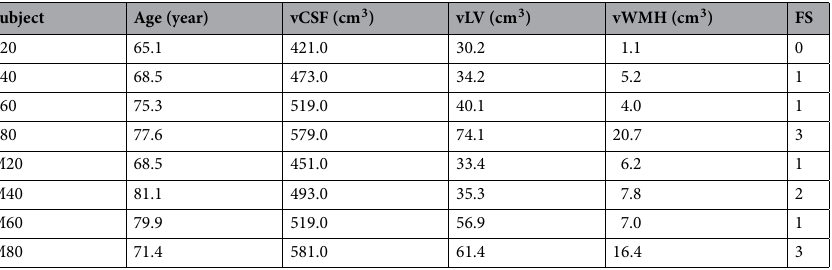
Table 1. Summary of subject data including age, CSF volume (vCSF), lateral ventricle volume (vLV), WMH volume (vWMH), and Fazekas score (FS). We selected eight representative cognitively normal subjects from the 20th, 40th, 60th, and 80th percentile of CSF volume.